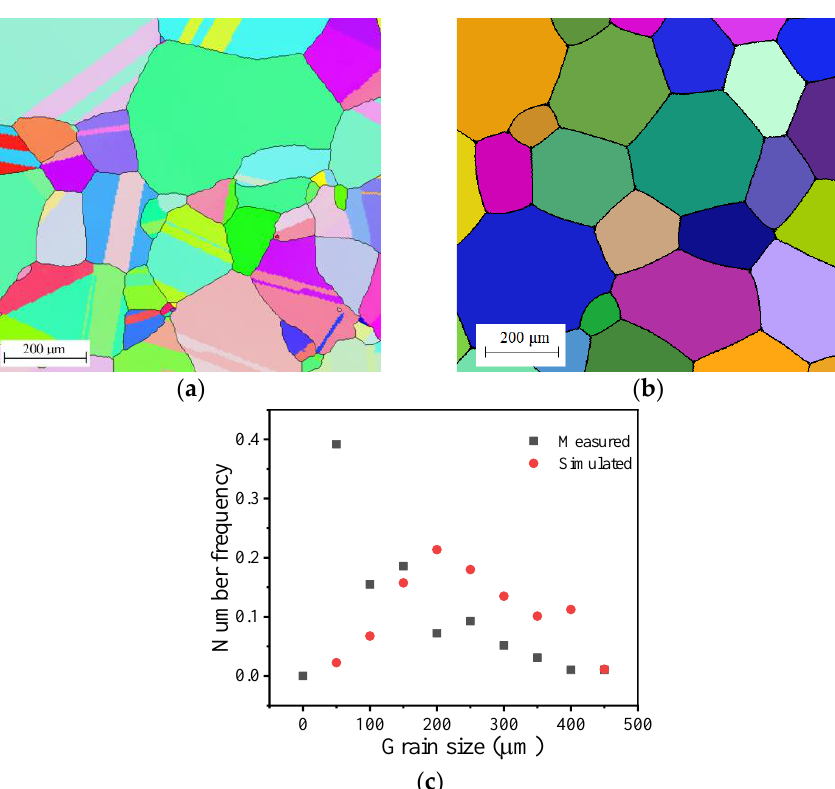
Figure 10. Comparisons between measured and simulated grain structure: ( a ) measured; ( b ) simu- lated; ( c ) grain number frequency.